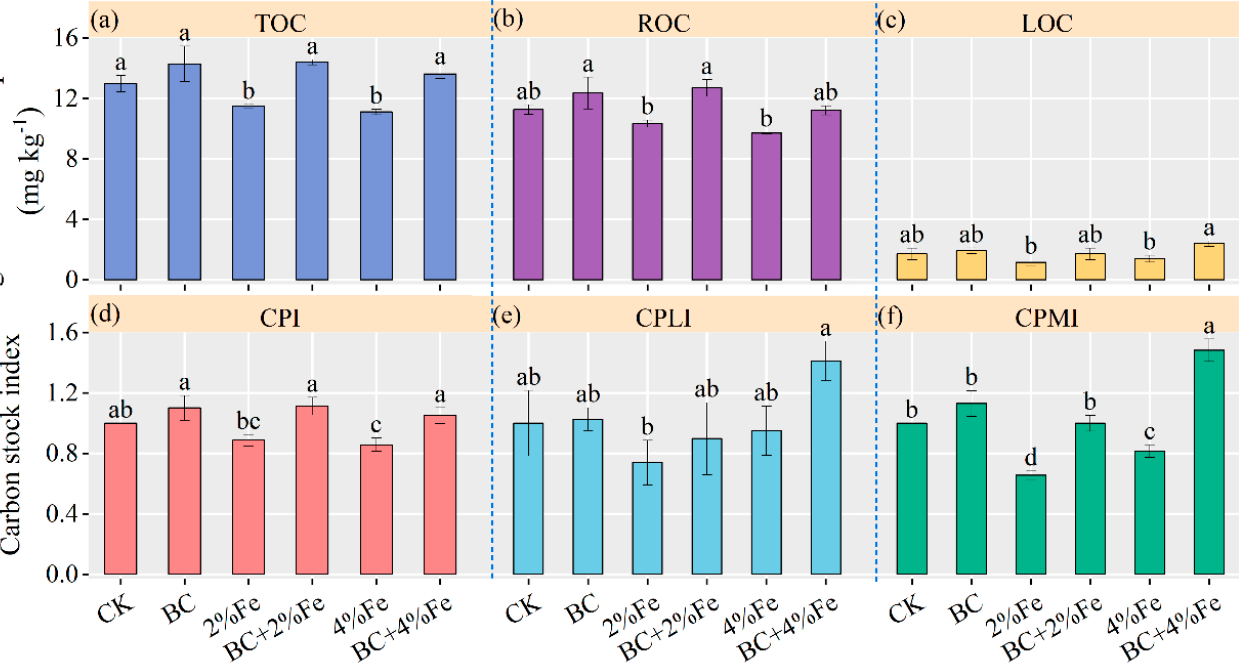
Figure 5. ( a ) Soil total organic carbon (TOC), ( b ) recalcitrant organic carbon ( ROC ), ( c ) labile organic carbon (LOC), ( d ) carbon pool index ( CPI ), ( e ) organic carbon pool labile index ( CPLI ), ( f ) carbon pool management index ( CPMI ) for different treatments. The data are presented as mean (±standard error). Different lowercase letters indicate significant differences between different treatments at p < 0.05.